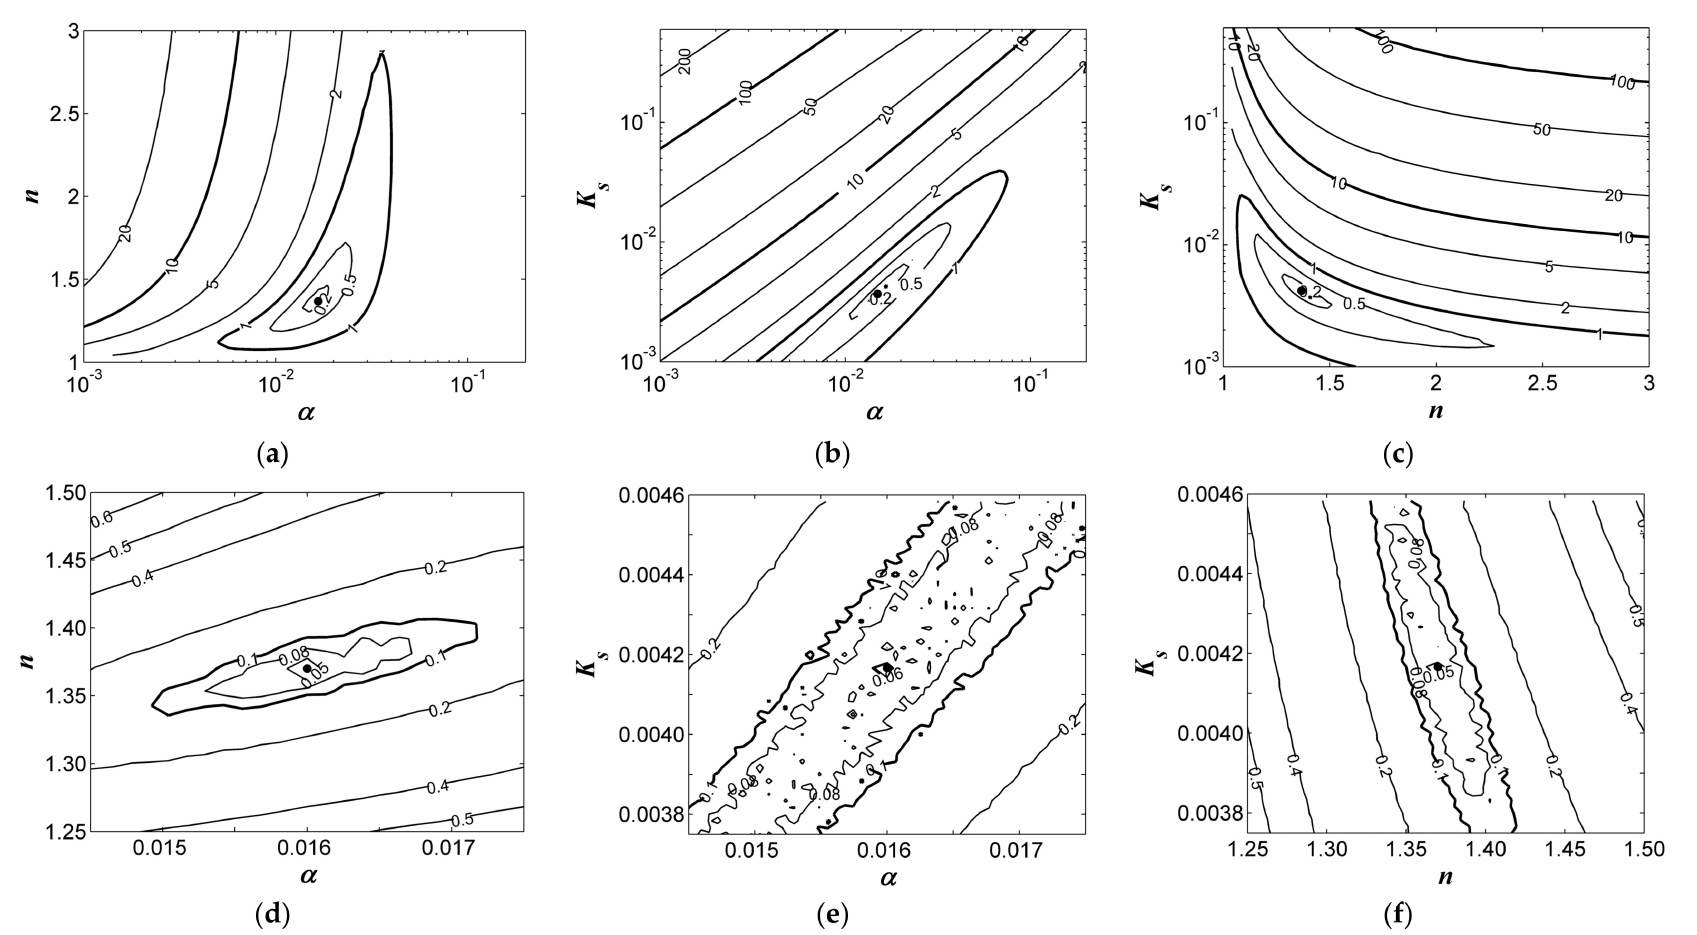
Figure 5. Contours of objective function ψ ( v ) of silt under θ initial equal to a 40% effective saturation degree. The hydraulic parameters of silt: θ r = 0.034 cm 3 cm − 3 ; θ s = 0.46 cm 3 cm − 3 ; α = 0.016 cm − 1 ; n = 1.37; K s = 0.0042 cm min − 1 . Results are plotted in the: ( a , d ) α – n ; (b, e) α – K s ; and ( c , f ) n – K s parameter planes. ( a – c ) depict the global scale, while ( d – f ) depict the local scale near the minimum. The solid circles are the true